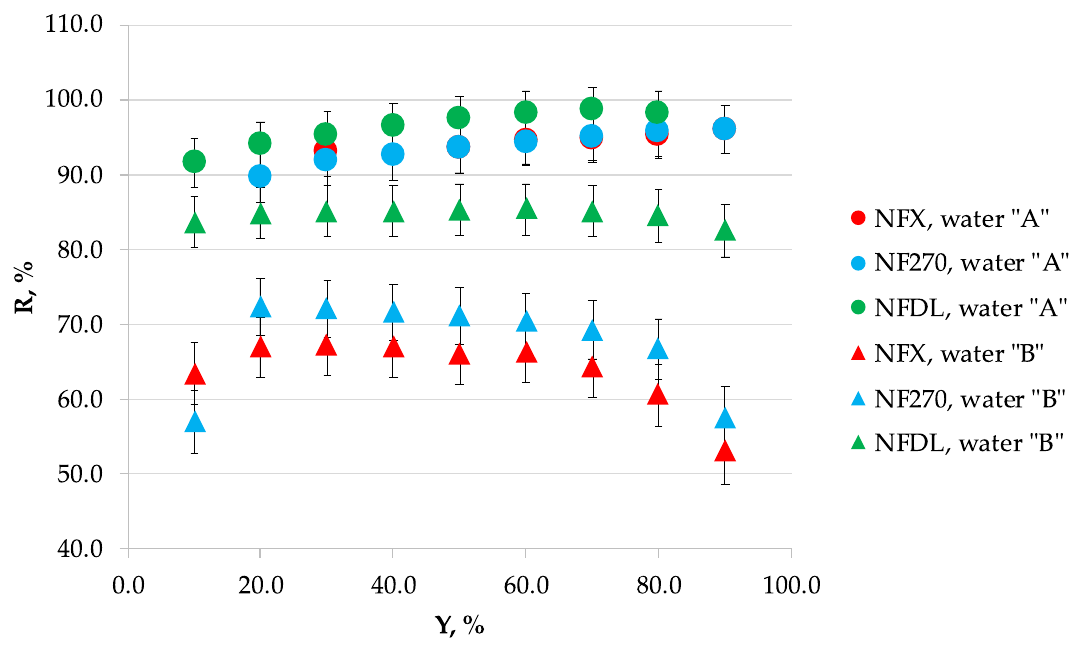
Figure A3. Rejection coefficient, R, of Ca 2+ as a function of permeate recovery, Y, for NFX, NF270 and NFDL nanofiltration membranes and mine waters “A” (0.384 g/L as Cl − , 1.02 g/L as SO 42 − , 0.107 g/L as Na + , 0.142 g/L as Mg 2+ , 0.312 g/L as Ca 2+ ) and “B” (33.2 g/L as Cl − , 0.937 g/L as SO 42 − , 19.5 g/L as Na + , 0.990 g/L as Mg 2+ , 0.771 g/L as Ca 2+ ).